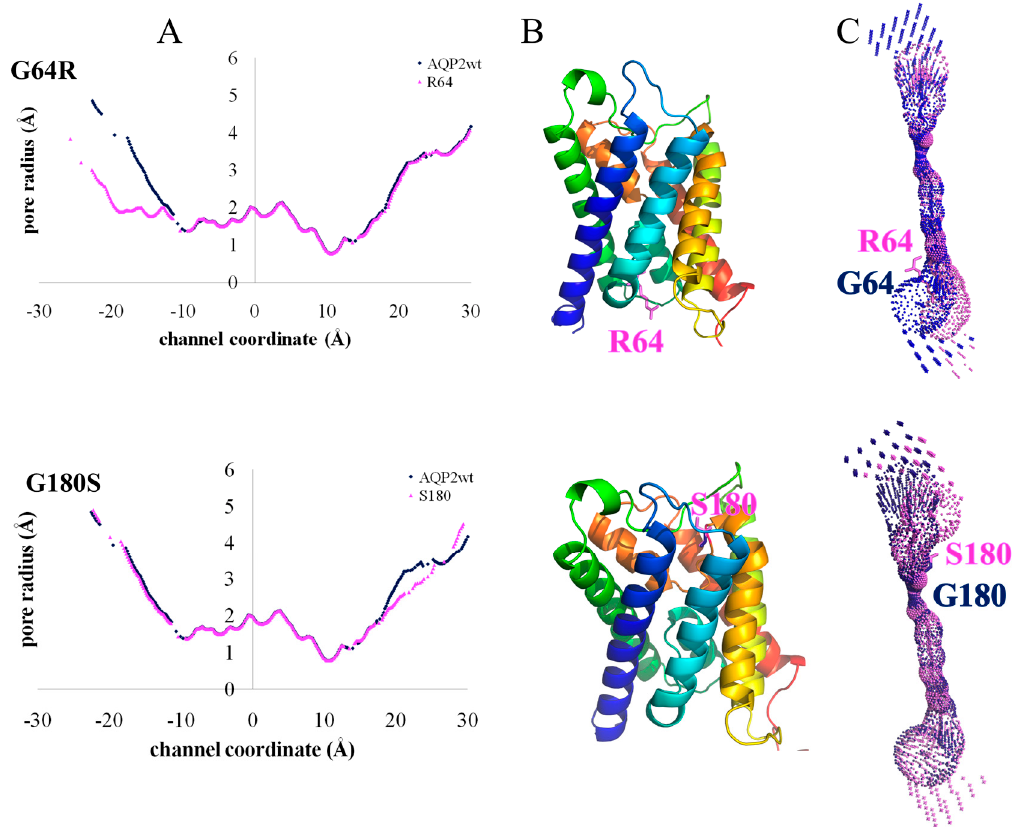
Figure 3. Mutations causing pore narrowing. ( A ) Pore radius along the channel axis for AQP2 wild type (blue) and mutants (violet); ( B ) cartoon representation of mutant models with mutated residues in violet sticks; ( C ) pore surface dimensions of AQP2 wild type (blue spheres) and mutants (violet spheres) calculated with HOLE [49].